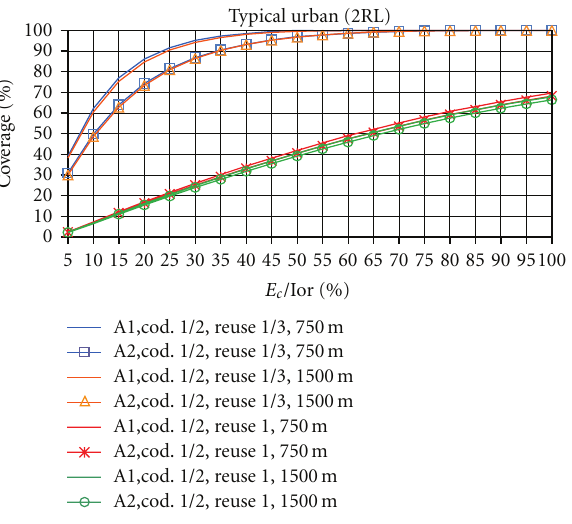
Figure 14: MIMO coverage (%) versus E c /Ior (%), for SC-PTM scenario, cod. 1 / 2.